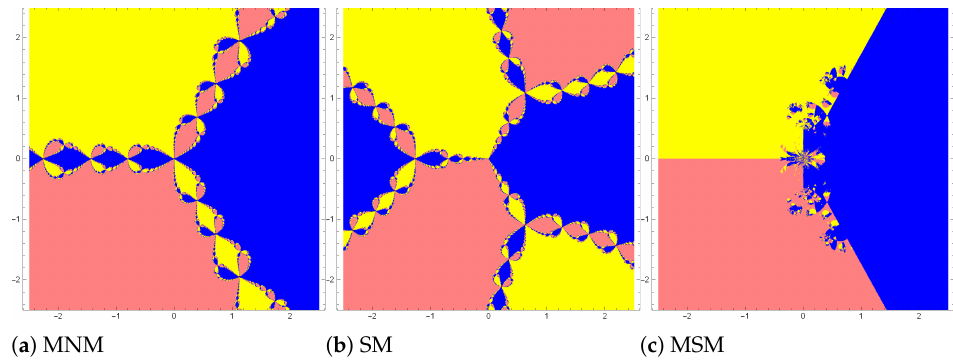
Figure 4. Dynamical planes of new and existing methods for Example 8.